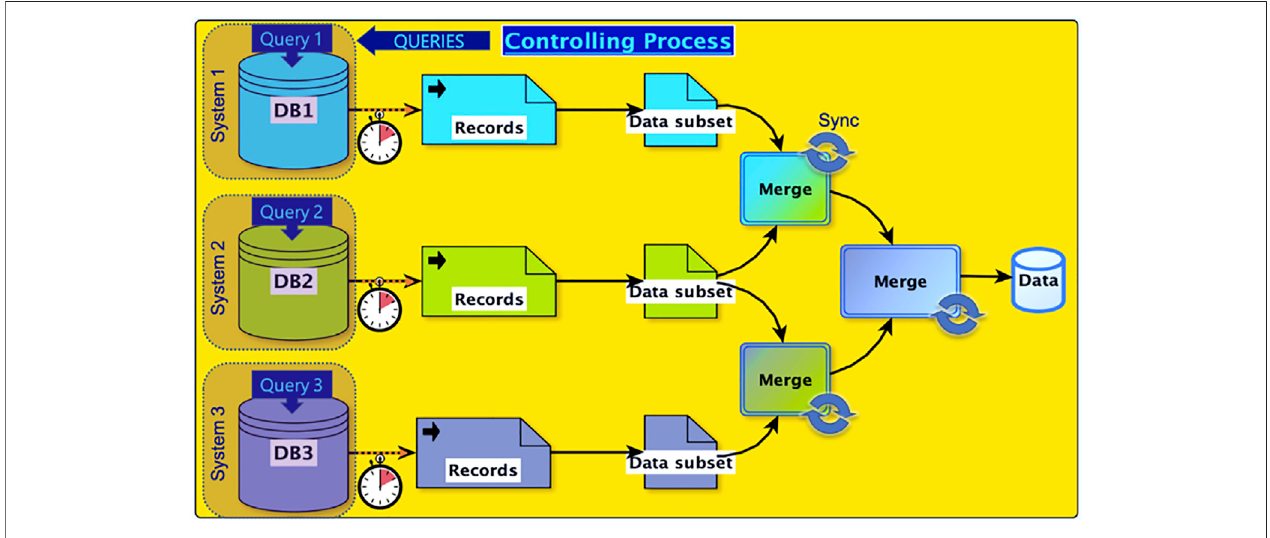
FIGURE 1 | Data fl ow in a hypothetical study involving federation of three separate databases. An application sends query requests to the three databases. Each database processes the query according to its server load, policies, maintenance cycle, and other factors. Because data records need to be merged, a synchronization step is required. Dotted arrows indicate transfers via the internet. The fi gure depicts a simple architecture involving 2-way merges. The number of steps and the computationalcostofamergeisapplication-dependent,involvingbufferlengths,differentiallatencies,formatconversions,semantictranslations,andotherfactors.